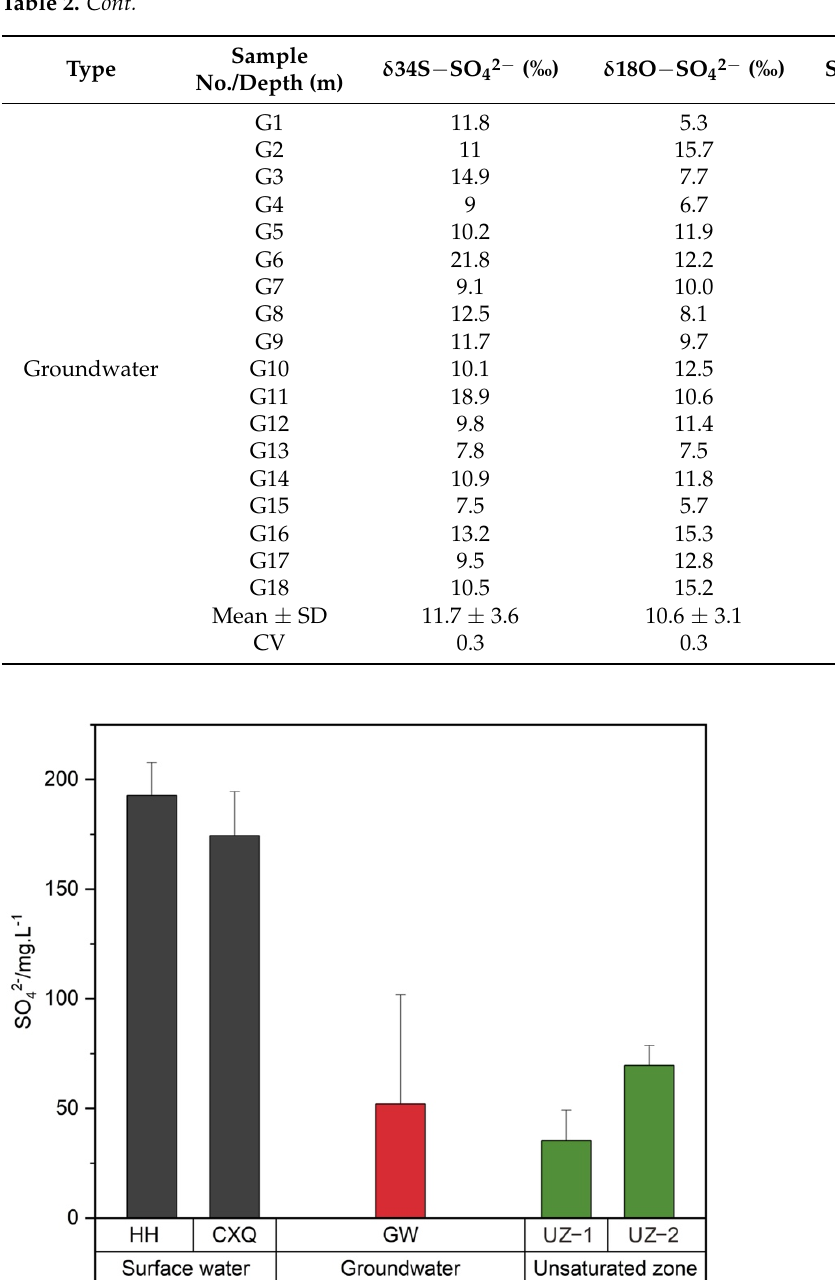
Figure 4. Variations in mean SO 42 − concentration in the surface water, groundwater and soil profile samples in the coal mining area.